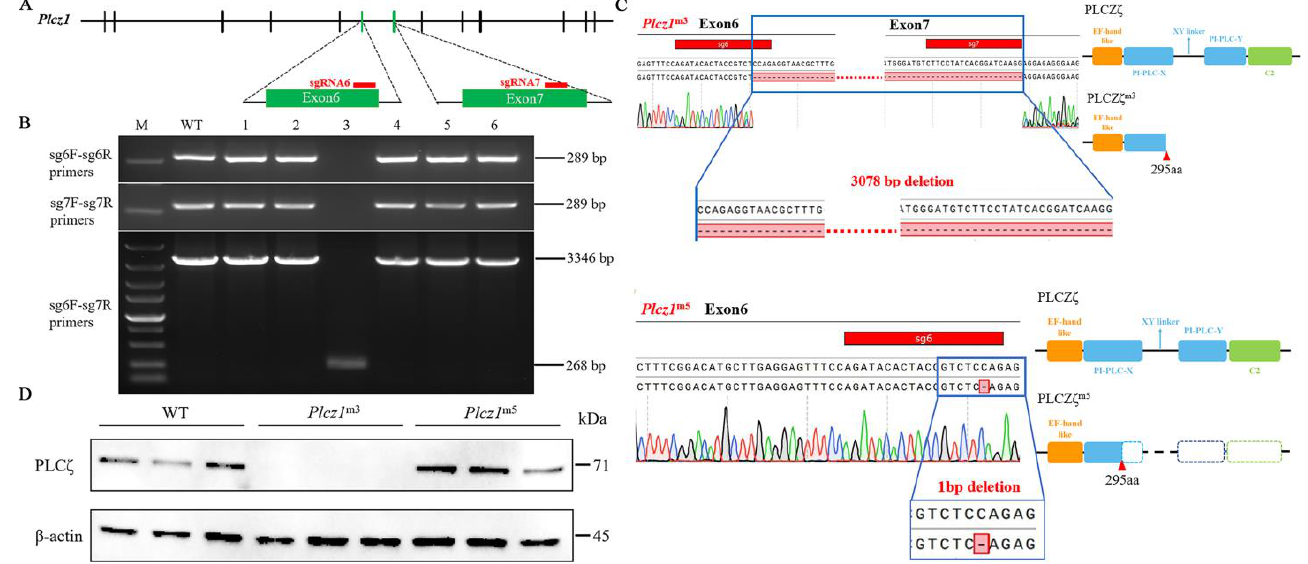
Figure 1. Recombinant vector sequencing and identification of Plcz1 − / − mice. ( A ) Gene structure of the mouse Plcz1 gene and target sequences (red lines) for CRISPR-Cas9. Exons are represented by vertical bars. ( B ) Identification of Plcz1 gene mutation by using PCR: M, DL5000 marker; WT, wild type. ( C ) Comparison of genomic sequences from the WT allele and three mutant Plcz1 alleles har- bouring nucleotide deletions. The missing sequence is shown in red and marked with a dotted line. Predicted protein-domain structures for WT and truncated proteins resulting from the mu-